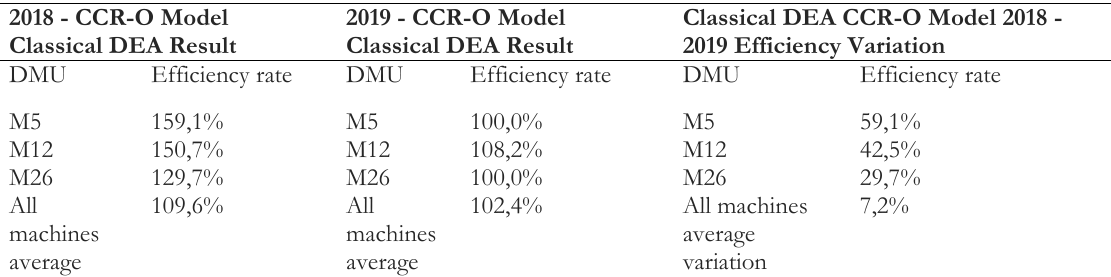
Table 3. CCR – output-oriented classical DEA results and efficiency variations.